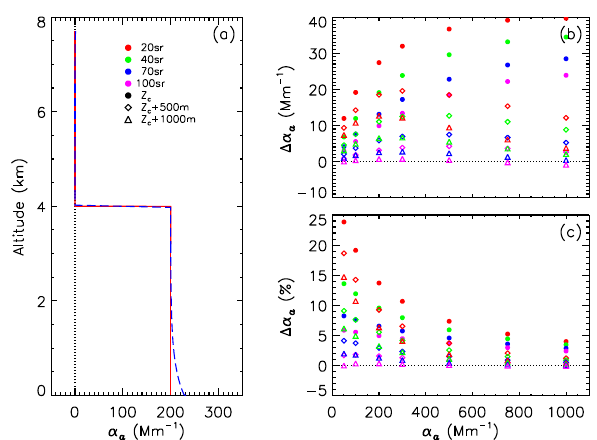
Fig. 3. Lidar signal simulation with a constant aerosol profile. (a) Red solid line: example original profile with α 0a =200 Mm − 1 and S 0 =70 sr; dashed blue line: corresponding retrieved profile obtained with the slope-Fernaldmethodwithareferenceheight Z c =500 mand S = S 0 . Similarsimulationsarecarriedoutfor several values for α 0a and S 0 . (b, c) Difference ∆ α a , between theretrieved and theoriginal profileatgiven fixedaltitudes,inabsoluteandrelativeterms,respectively. Differentcoloursindicatedifferentlidarratioes S 0 : red, 20sr; green, 40sr; blue, 70sr; andmagenta, 100sr. Differentsymbolsindicatedifferentaltitudeswhere ∆ α a isevaluated: solidcircles, Z c ;diamonds, Z c +500 m;triangles, Z c +1 km.